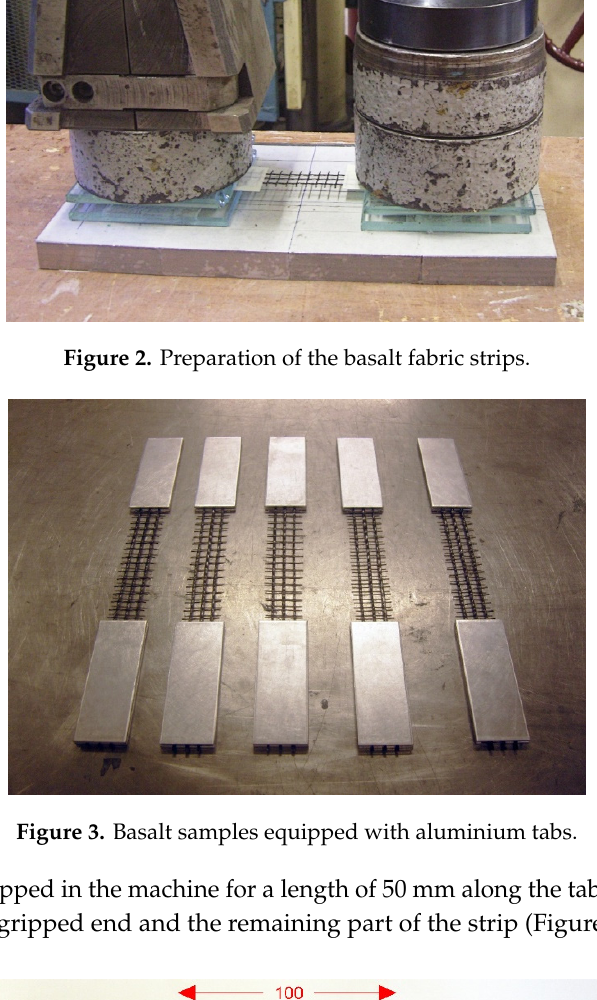
Figure 4. Basalt textile sample before testing.